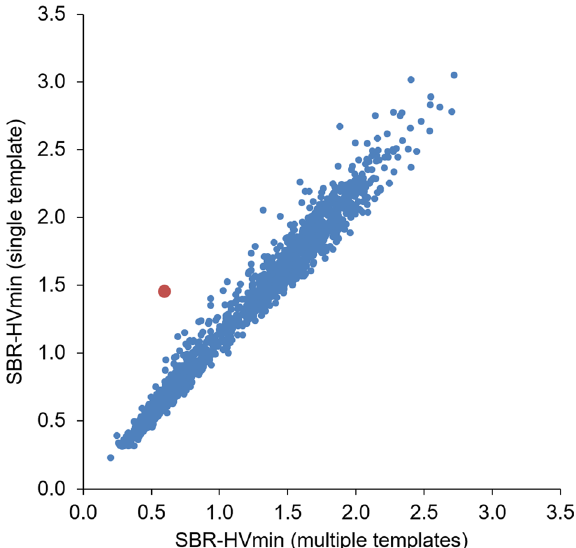
Fig. 6 Scatter plot of the putamen SBR with the two normalization methods. The scatter plot shows the minimum hottest voxels putamen SBR obtained with the single normal template as target for stereotactical normalization versus stereotactical normalization with multiple templates. The normalized DAT-SPECT image of the outlier (red dot) is shown in Fig.